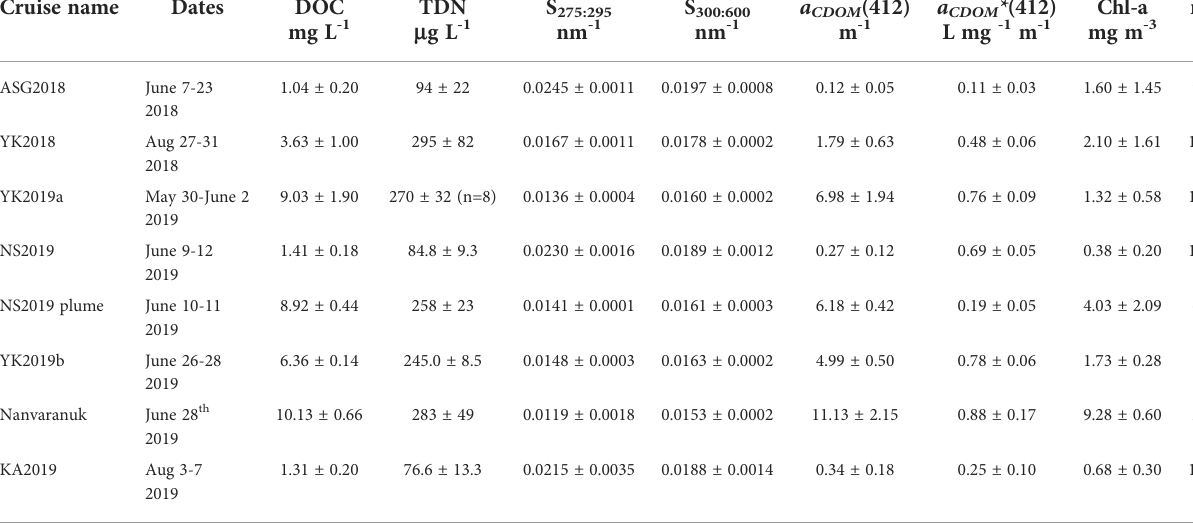
TABLE 1 Means and standard deviations of biogeochemical (dissolved organic carbon [DOC mg L -1 ], total dissolved nitrogen [TDN m g L -1 ], Chl a [chlorophyll-a mg m -3 ] and CDOM optical properties (CDOM spectral slope between 275-295 nm [S275:295 nm-1], and 300-600 nm [ S 300:600 nm -1 ], and a CDOM (412)(m -1 ) by region and fi eld